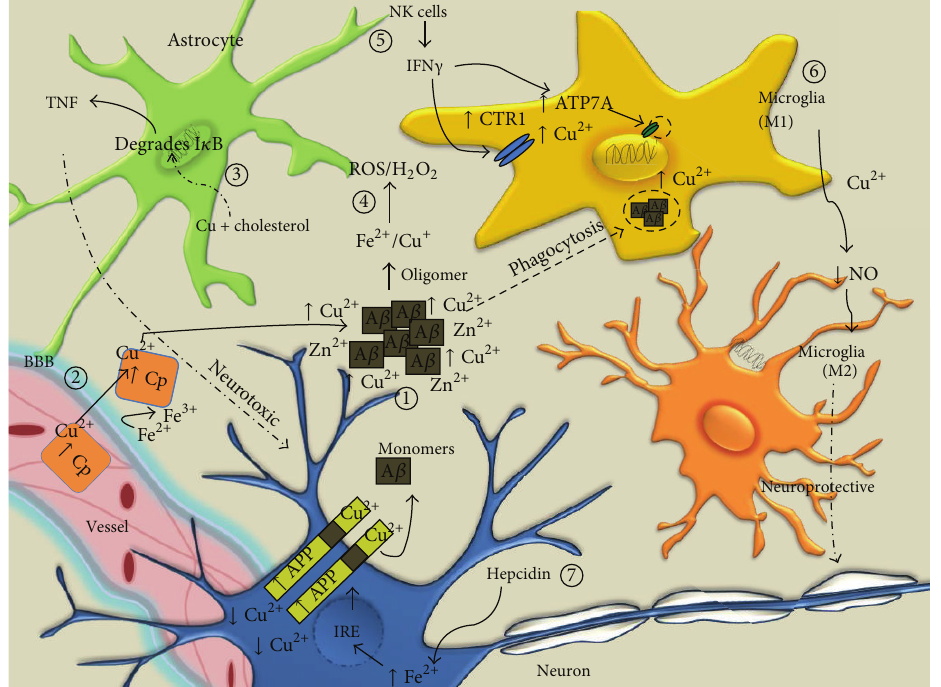
Figure 2: Hypothesised roles of copper in the inflammatory process of AD. (1) Clockwise from center. Cu and Zn induce the aggregation of A 𝛽 in AD, leading to reduced neuronal intracellular bioavailable Cu. This may account for the reported reduced expression of the Cu-requiring proteinsSOD1andATOX1inAD.(2)Cp,theCu-transportprotein,whichiselevatedinAD,canpromoteFeoxidation,inflammation[28],and increased extracellular Cu levels in the CNS. (3) Copper has been shown to potentiate the effects of cholesterol on inflammation-induced A 𝛽 neurotoxicity through increased TNF production [30]. (4) APP or A 𝛽 reduce Cu 2+ to Cu + —this redox cycling promotes production of ROS including H 2 O 2 . (5) NK cell-derived IFN 𝛾 can increase Cu uptake in microglia via enhanced CTR1 expression [27]. IFN 𝛾 also promotes ATP7A elevation and vesicular trafficking. These mechanisms of Cu sequestration by microglia may prevent further plaque formation. Phagocytosis of amyloid plaques also raises microglial Cu levels and promotes A 𝛽 clearance. (6) Cu may polarize inflamed microglial populations from the neurotoxic (M1) phenotype to the neuroprotective (M2) phenotype via inhibition of NO production [31]. (7) The Fe master regulator, hepcidin, is induced by cytokines in AD and prevents Fe release from neurons. Excess Fe binds IREs in the APP promoter and upregulates APP production, promoting Cu export and